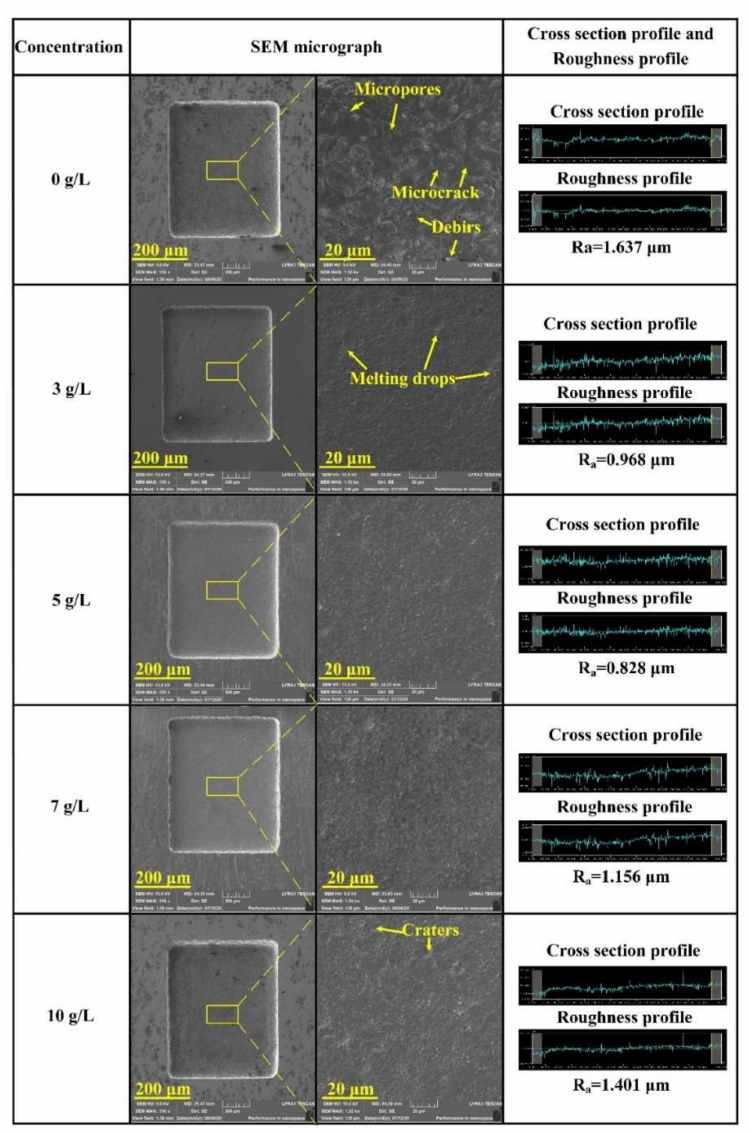
Figure 10. E ff ect of di ff erent TiC concentrations on surface roughness and SEM micrographs of the microcavities